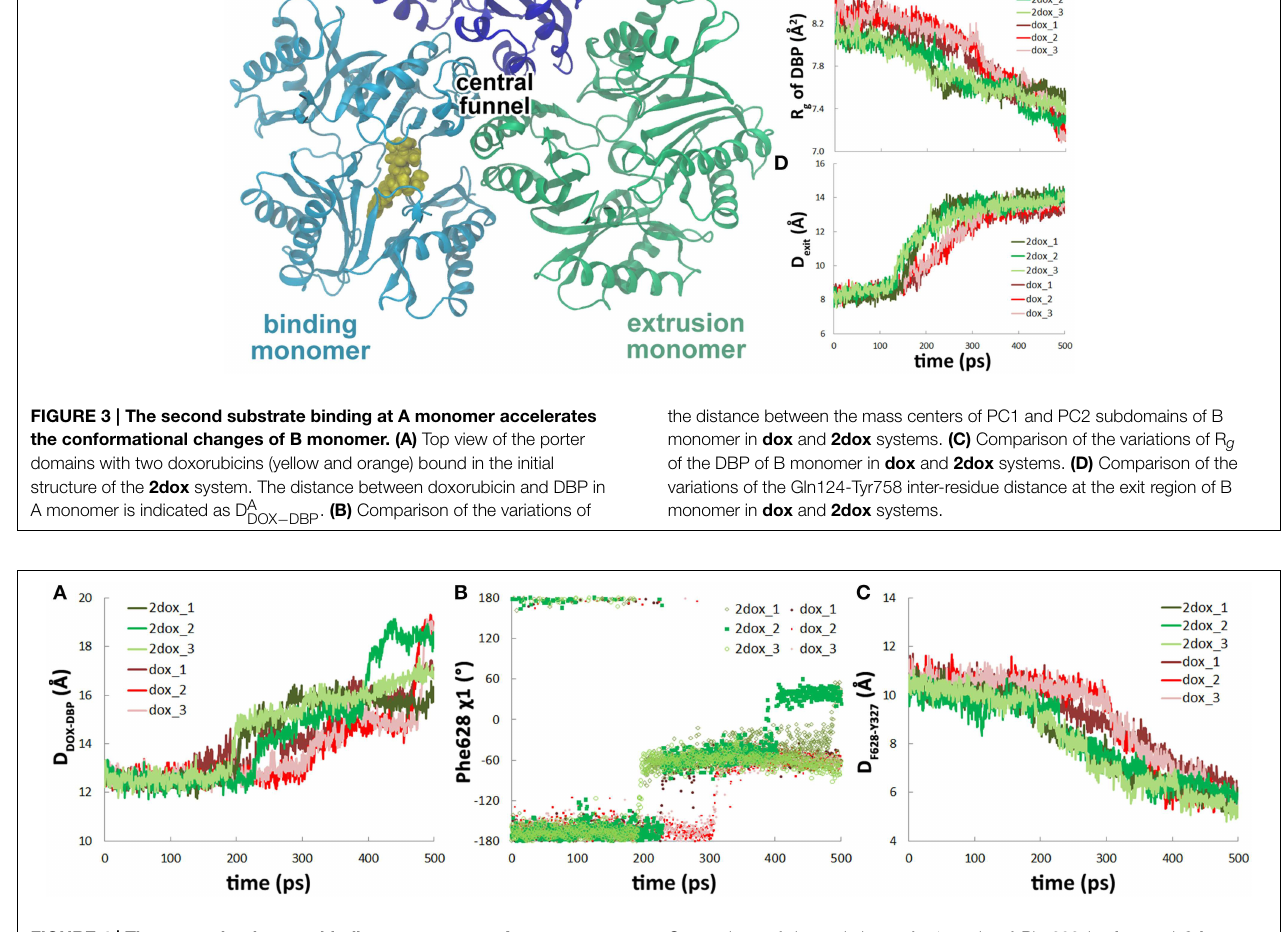
Comparison of the variations of χ 1 angle of Phe628 in dox and 2dox systems. (C) Comparison of the variations of the distance between the mass center of Tyr327 side chain and the C α atom of Phe628 in dox and 2dox